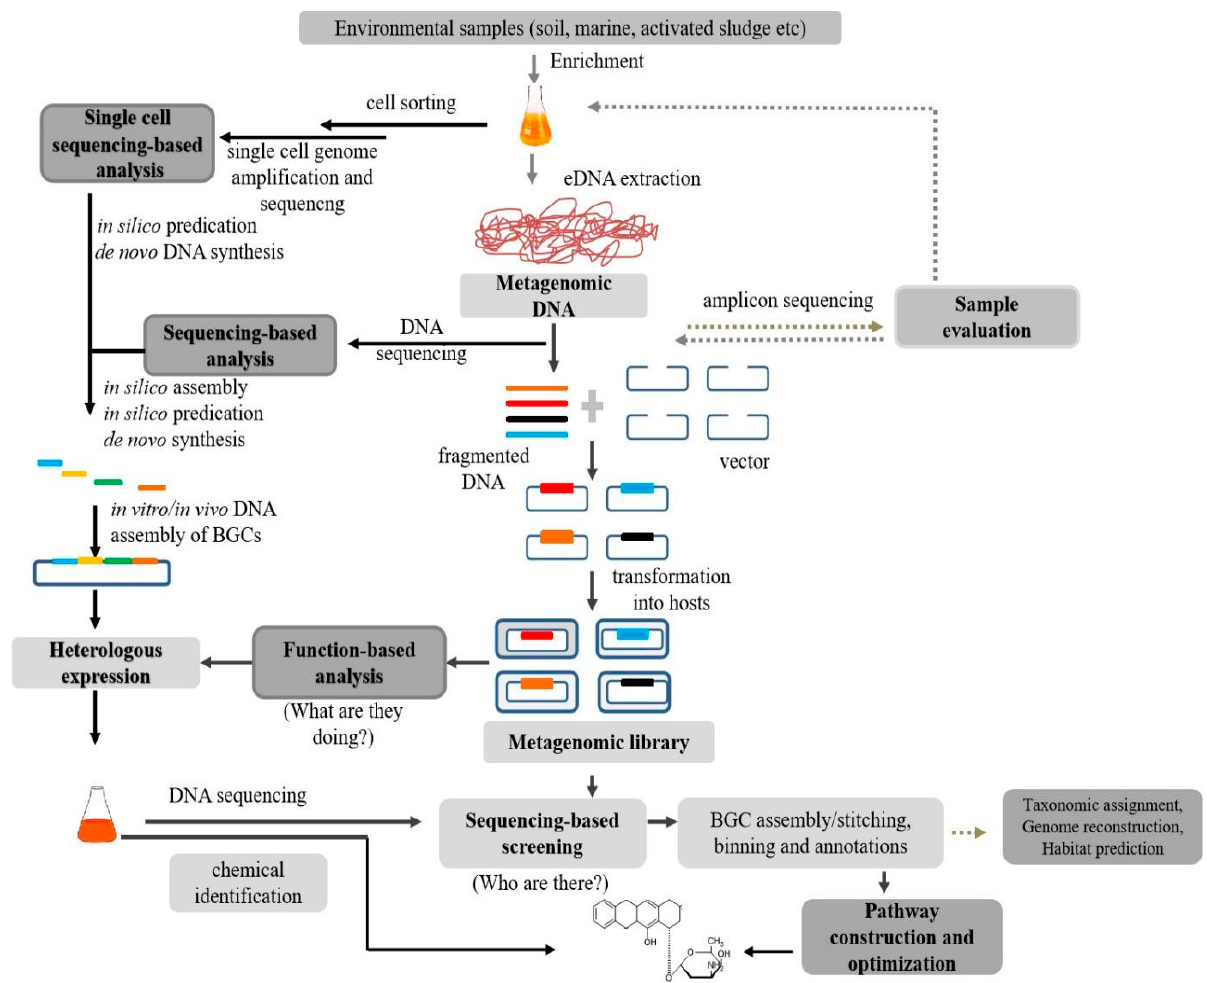
Figure 1. Graphical representation of approaches for NP discovery from environmental samples. Enrichment and evaluation of environmental samples are necessary steps prior to metagenomics analysis. Function-based metagenomics analysis includes library construction, heterologous expression, and function-based screening. Sequencing-based metagenomics analysis requires eDNA sequencing, DNA synthesis and assembly, and heterologous expression of target clones. Single-cell metagenomics analysis includes cell sorting, single cell genomic DNA amplification, genome sequencing, and DNA synthesis and assembly of NP biosynthetic gene clusters (BGGs) of interest, then expression and chemical identification.